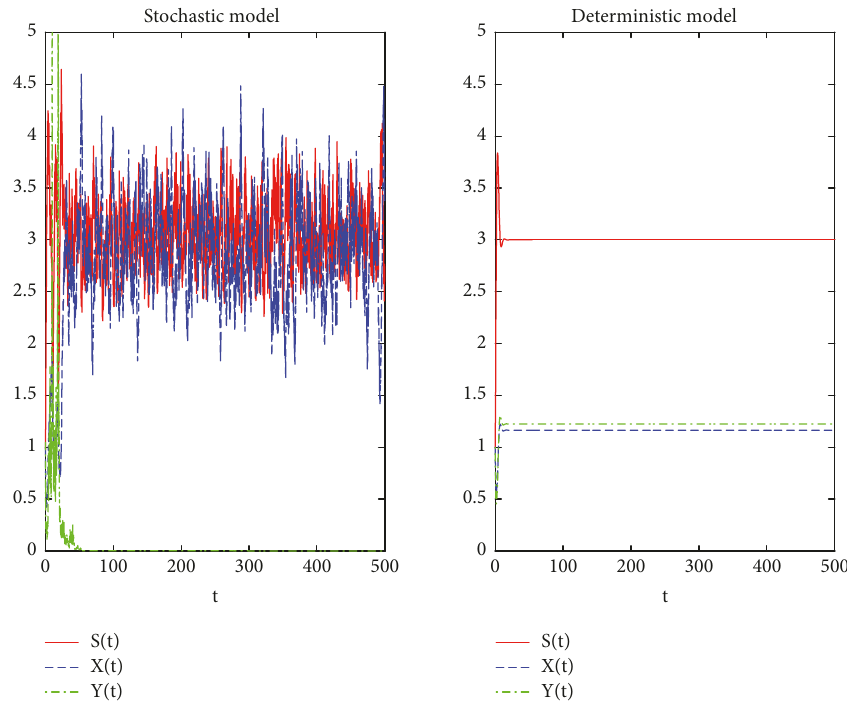
Figure 6: Numerical simulation of thesolution of system(2)and itscorresponding deterministicsystem(1)with 𝜎 1 = 0.1, 𝜎 2 = 0.1, 𝜎 3 = 0.6 , with initial value 𝑆(0) = 1, 𝑋(0) = 1, 𝑌(0) = 1